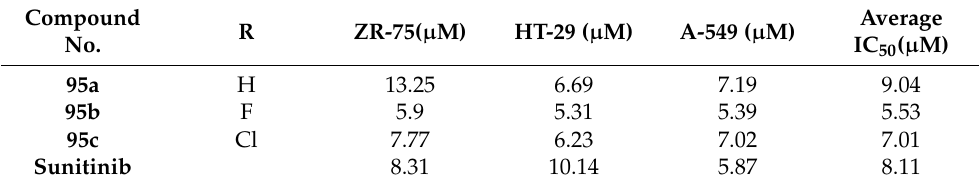
Figure 92. Structure of isatin-based benzoazine derivatives ( 95 ). Table 82. In vitro cytotoxic activities of isatin-based benzoazine hybrid compounds 95 ( a – c ). Compound No.